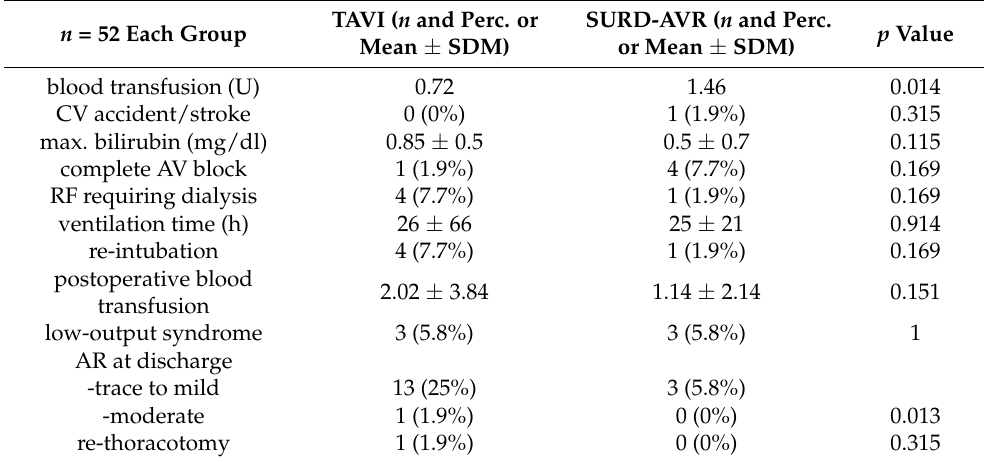
Table 2. Operative and postoperative data. TAVI ( n and Perc. or n = 52 Each Group